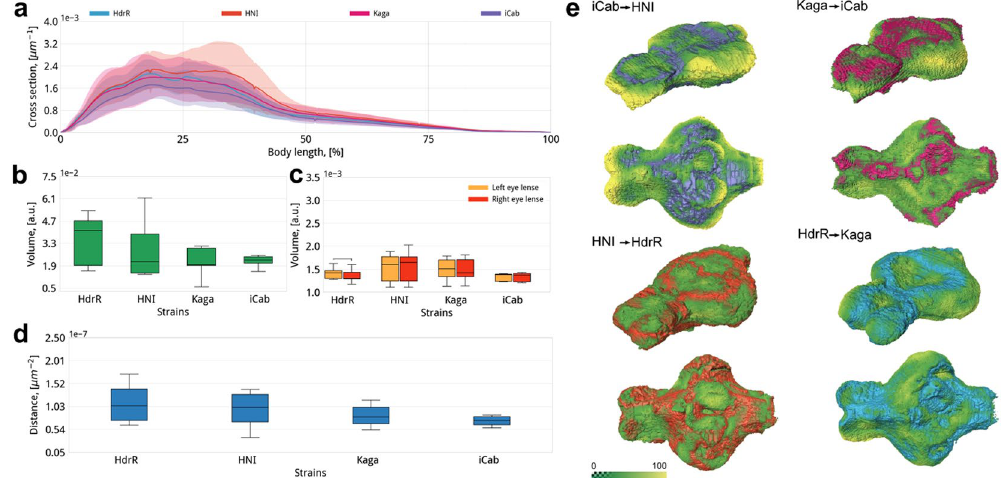
Figure 5. Comparative morphometric analysis ( a ) Comparison of cross sectional areas along the antero- posterior axis (position indicated as percent of the total length); the head region comprises the anterior 30% of the total length. Solid lines are the average area of the cross section per strain, the semi-transparent region shows the standard deviation. All parameters are normalized to the total volume of specimens. Cross sections of iCab head region are smaller than those of HNI, HdrR and Kaga. ( b–e ) Comparative analysis of quantitative morphological parameters between the four isogenic inbred strains. Number of specimen is 7, 8, 5 and 6 for HdrR, Kaga, iCab and HNI respectively. ( b ) Comparison of brain volume, which is smaller in Kaga and iCab than in HdrR. ( c ) Comparison of lens volumes, showing that iCab and HdrR lenses are smaller than those of HNI and Kaga ( d ) Comparison of the distance between the eyes, which is bigger in HdrR compared to iCab and Kaga ( e ) Comparison of 3D strain specific brain shape morphometrics, shown in violet, magenta, orange and cyan for iCab, Kaga, HNI and HdrR strains respectively; antero-lateral and ventral view of brains. The strain specific shape is overlaid with the displacement distances (color-coded: green → yellow) to indicate variation in micrometers for each strain to be transformed into another one (for example, iCab → HNI). Note that different transformation patterns emerge from the pairwise